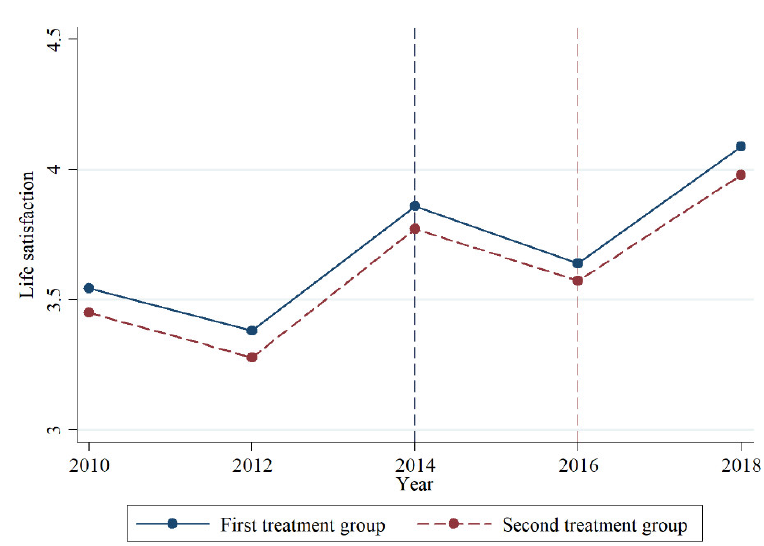
Figure A1. Changes in life satisfaction of different groups.